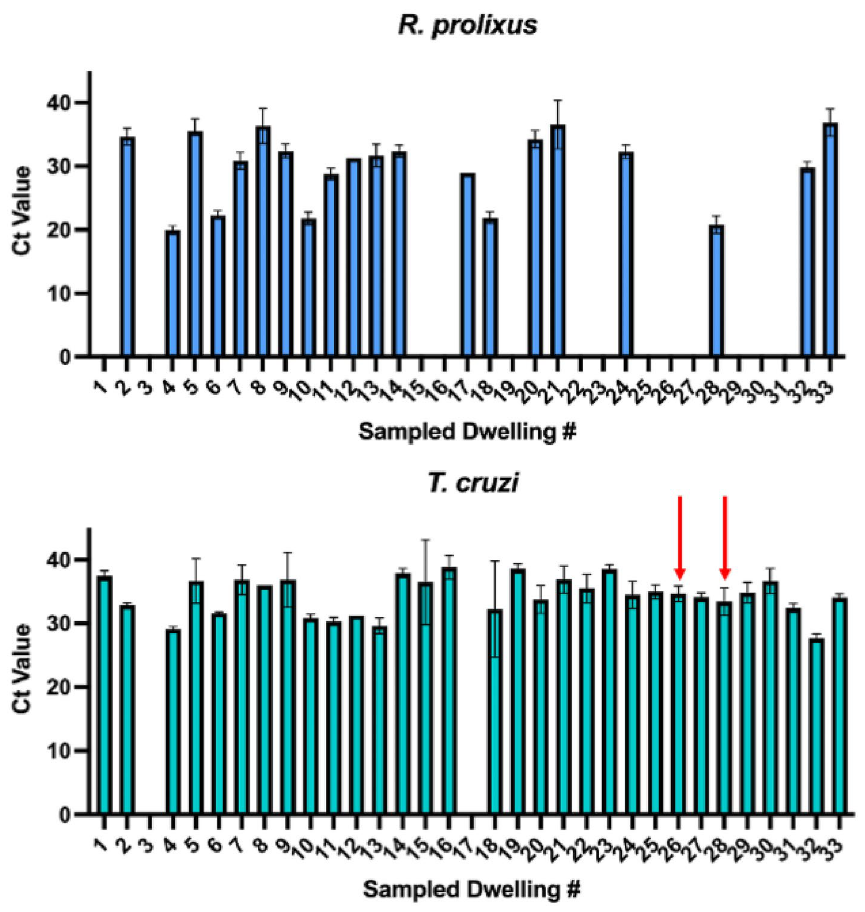
Figure 4. Detection of R. prolixus and T. cruzi eDNA from cotton swabs taken from 33 house with confirmed triatomine infestations in Casanare, Colombia. Red arrows indicate houses with reported human T. cruzi